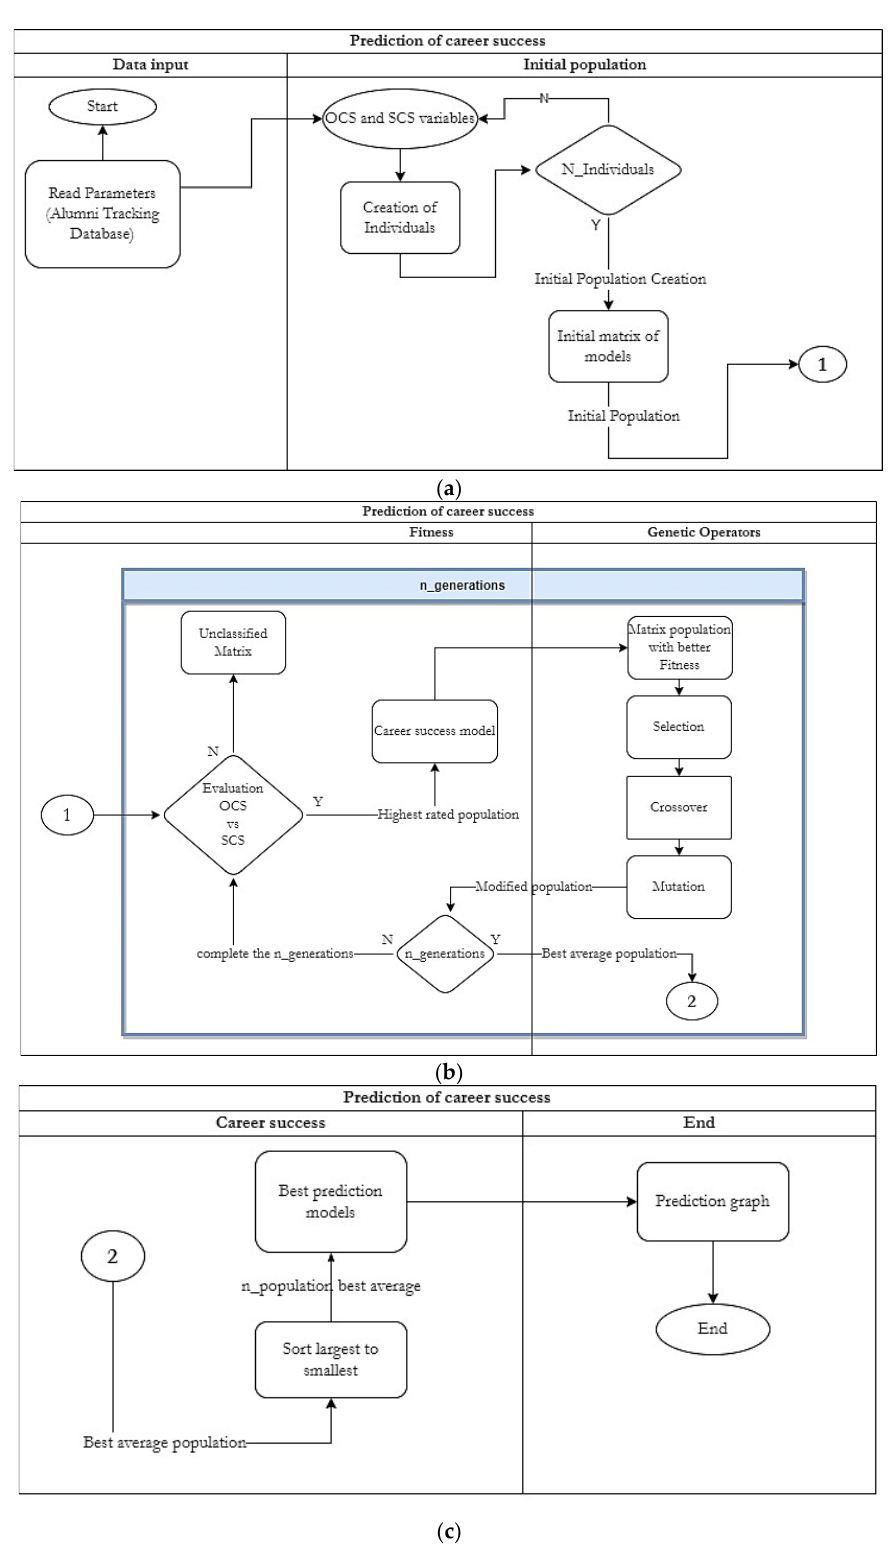
Figure 3. Design of the proposed algorithm. ( a ) Entry of monitoring parameters to graduates and creation of the initial population. ( b ) Fitness process and genetic operations such as crossover and mutation. ( c ) Professional success prediction